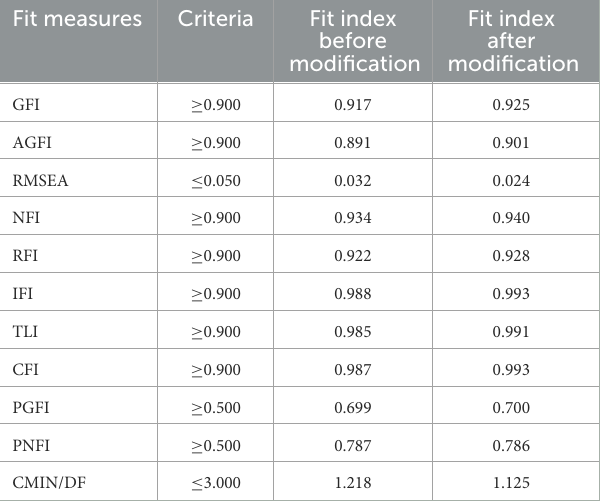
FIGURE4 Standardized five-factor structural model of Chinese DoCCA scale ( n = 217). D, demands, four items; UT, unnecessary tasks, three items; RC, role clarity, five items; NS, needs support, four items; GO, goal orientation, four items.